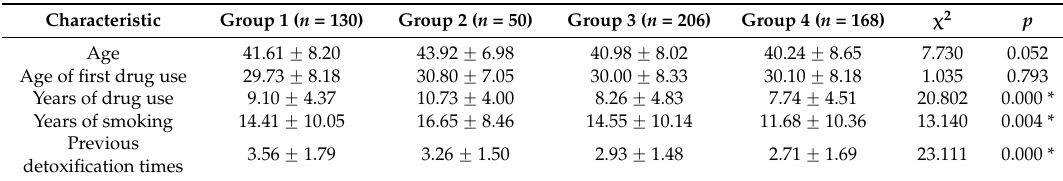
Table 2. Participant characteristics (2) Mean ˘ SD.